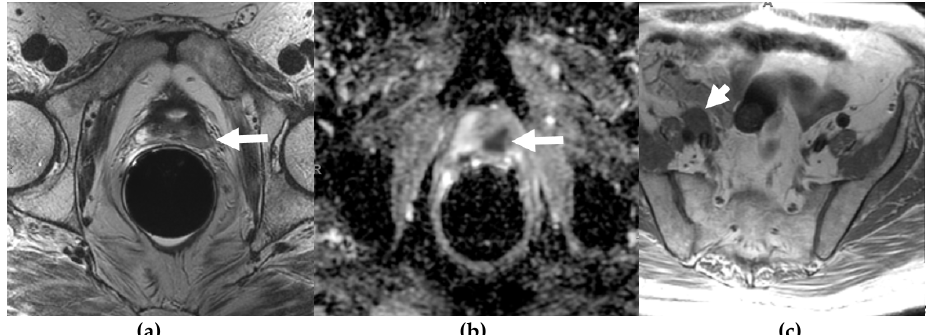
Figure 1. A 60-year-old man with lower retroperitoneal lymphadenopathy on PET-CT, found during work-up for dermatomyositis and abnormal digital rectal exam. T2W ( a ) and ADC ( b ) MR images through the prostate show a hypointense mass (long arrow) with restricted diffusion in the left posterolateral peripheral zone of the prostatic apex. Large field of view axial T1W MR image ( c ) of the pelvis shows right external iliac lymphadenopathy (short arrow). This was biopsy-proven metastatic small cell carcinoma of the prostate.